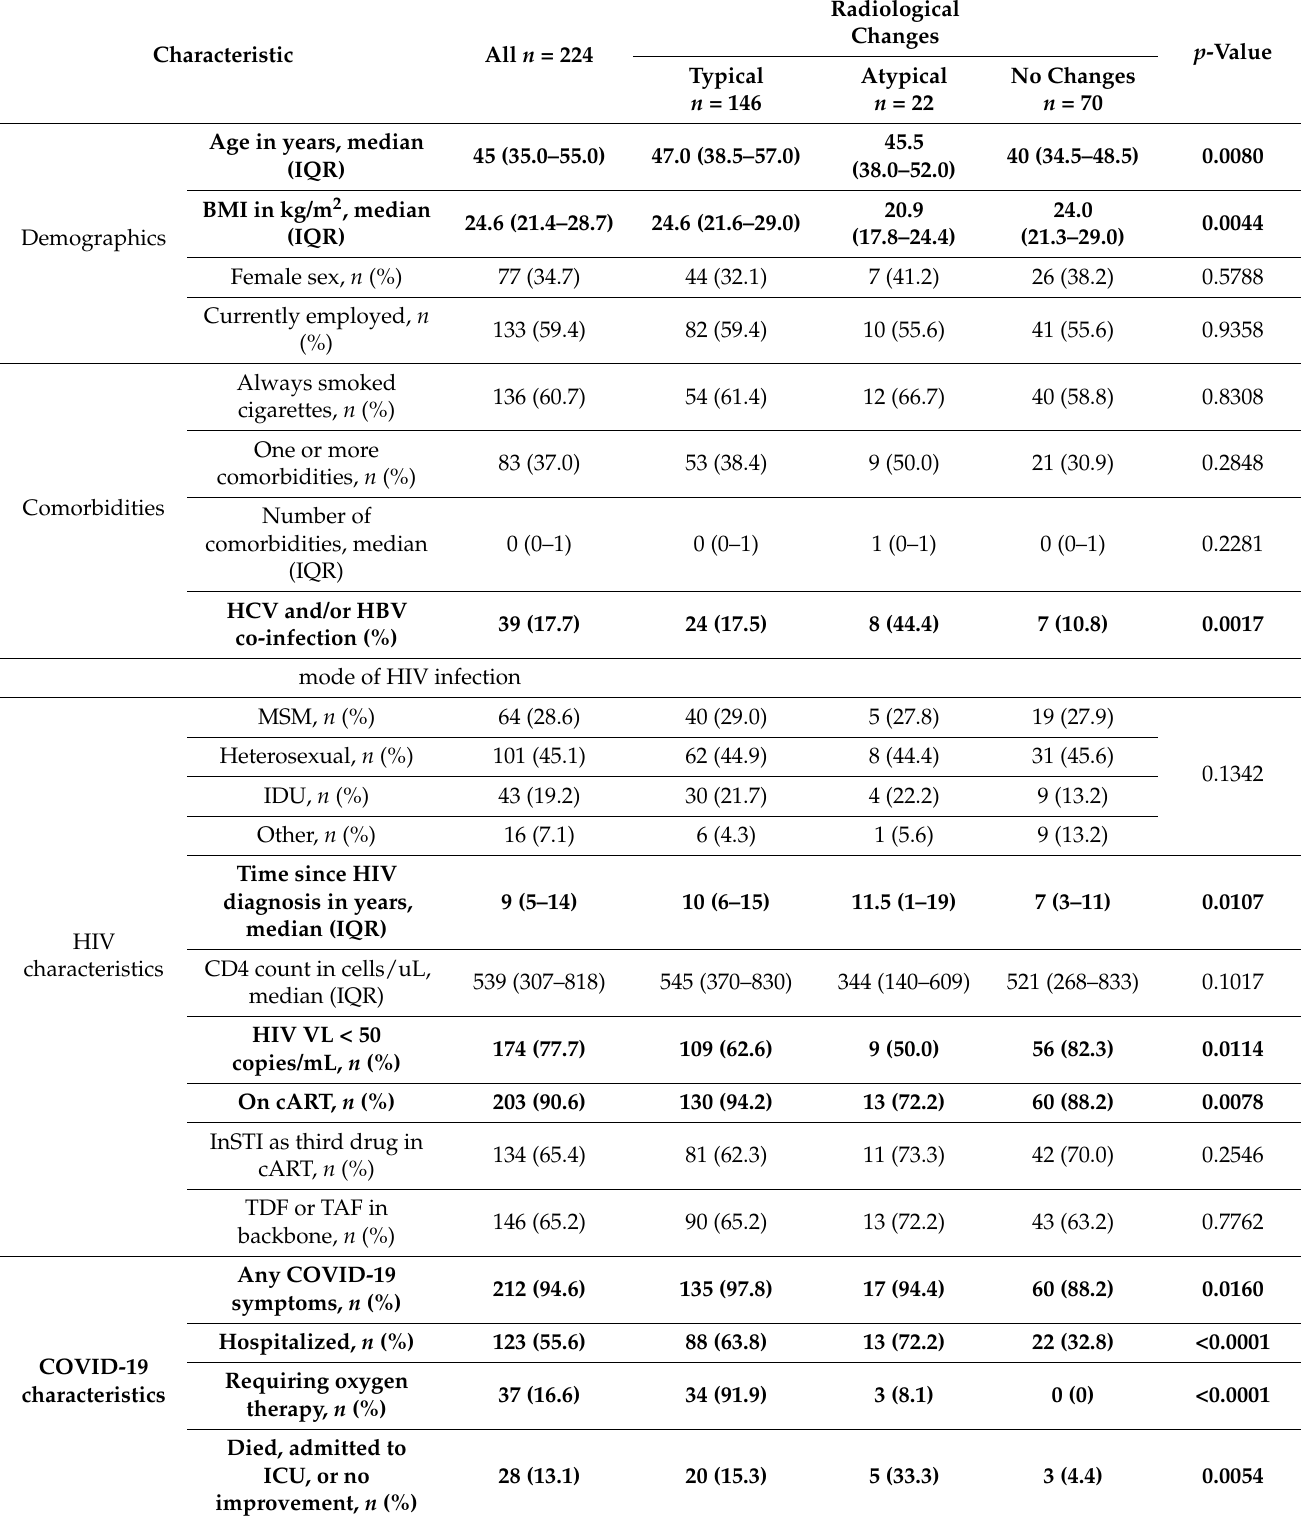
Table 1. Baseline characteristics of HIV/COVID-19 coinfected patients relating to the occurrence of radiological changes in chest X-rays or computed